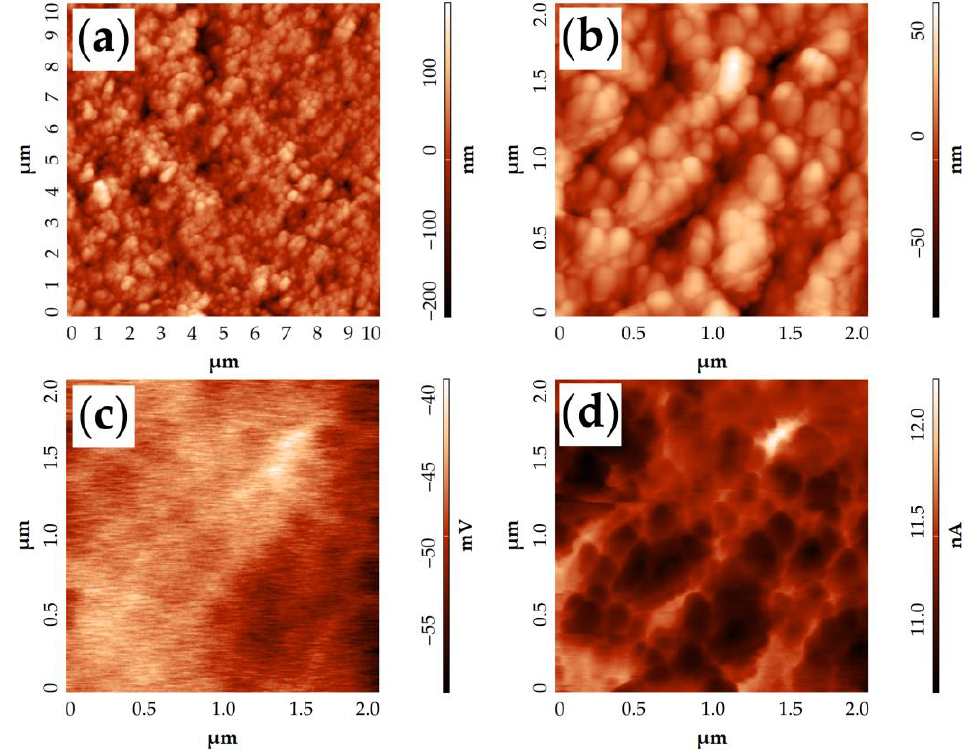
Figure 8. Co3O4 film AFM results: topography ( a , b ), surface potential distribution map ( c ) and capacitance gradient distribution map of “ probe tip – sample microregion ” capacitor ( d ).